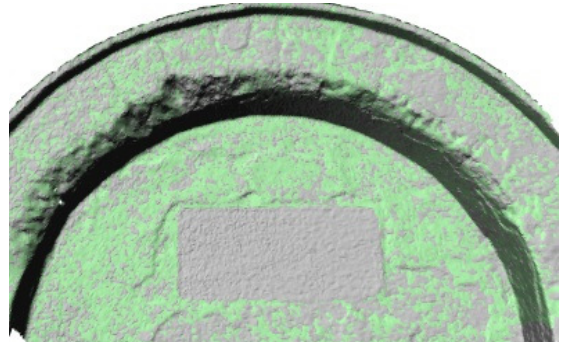
Figure 10. Per Scanner color mode rendering. Subproject